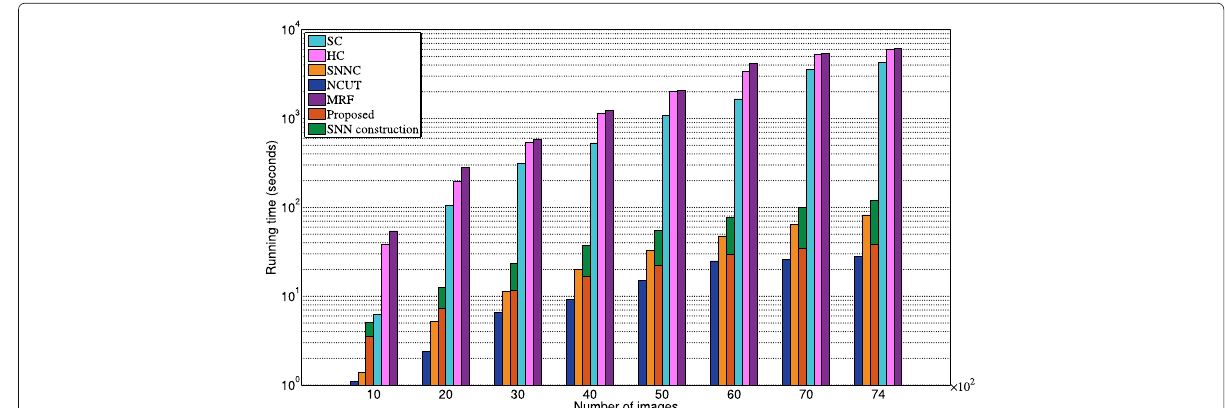
Fig. 3 Comparison of the running time (in seconds) of six clustering algorithms using SPNs of 1024 × 1024